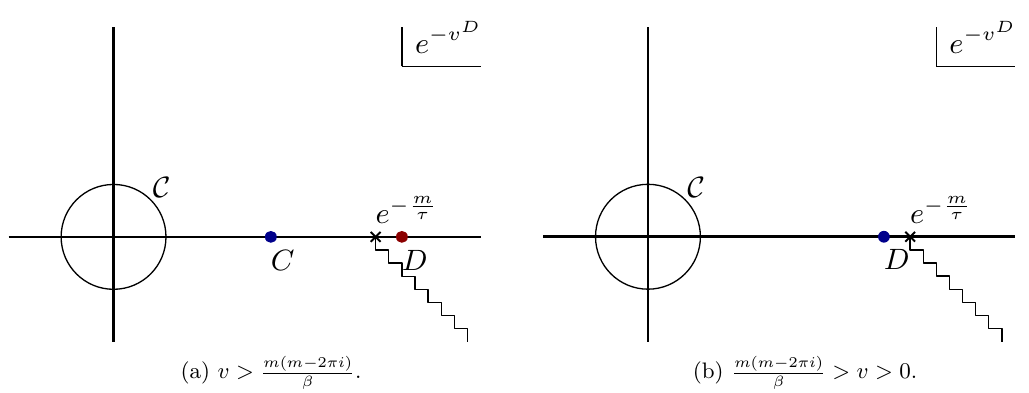
Figure 6. Contour C of the S-duality kernel integral. The cross denotes the branch point at e − v D = e − m/τ , and the wavy line denotes the branch cut whose direction is set not to cross the saddle points. The points C and D denote the confining and deconfining saddle points, respectively. The blue saddle point is the accessible saddle point, and the red saddle point is the inaccessible saddle